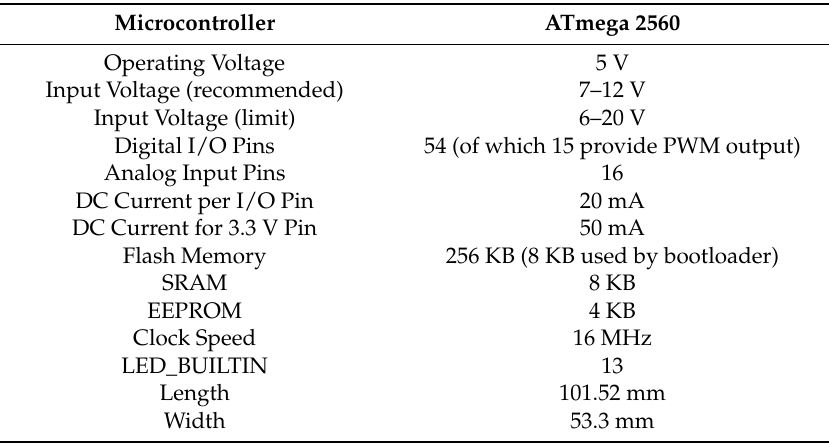
Figure 1. Diagram of the Arduino-Based Data Acquisition System (ABDAS) described in the present work. Table 1. Technical specifications of Arduino Mega 2560 [70].